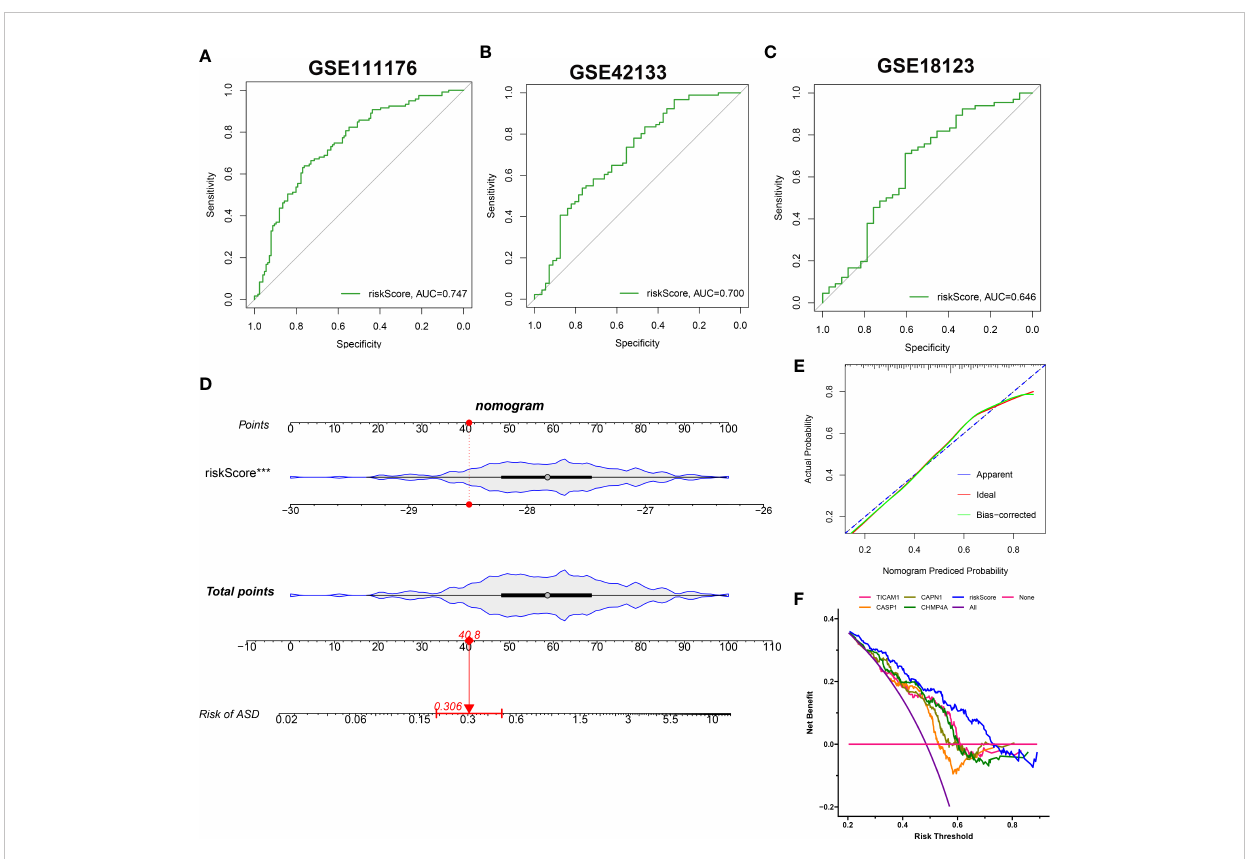
FIGURE 10 Construction and validation of the performance of 4-NRG diagnostic model. (A – C) ROC curves evaluating the diagnostic ef fi cacy of 4-NRG diagnostic model in GSE111176 (A) , GSE42133 (B) , and GSE18123 (C) . (D) Representative nomogram based on 4 characteristic NRGs for predicting ASD progression. Each variable corresponds to a score, and the scores of all variables are added together to calculate the total scores. (E) Representative calibration curve evaluated the diagnostic accuracy of the nomogram. (F) Representative DCA displayed the clinical bene fi t of the